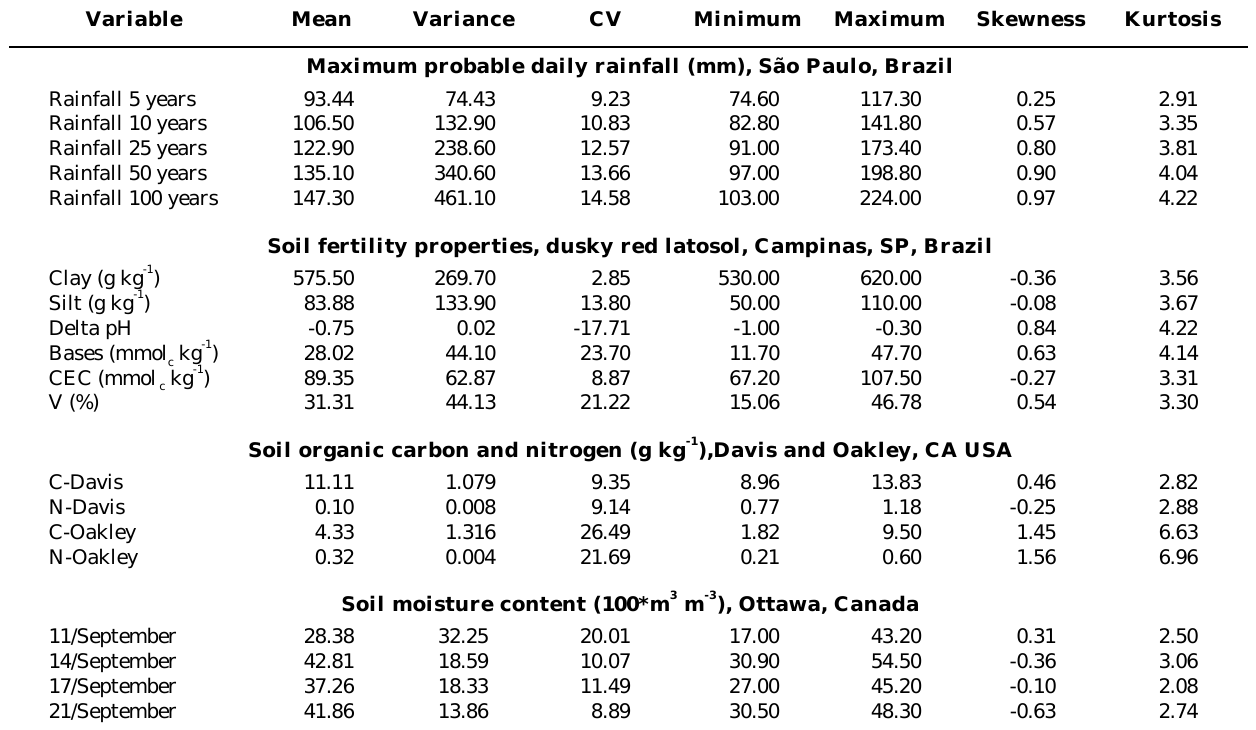
Table 1. Statistical moments for the data